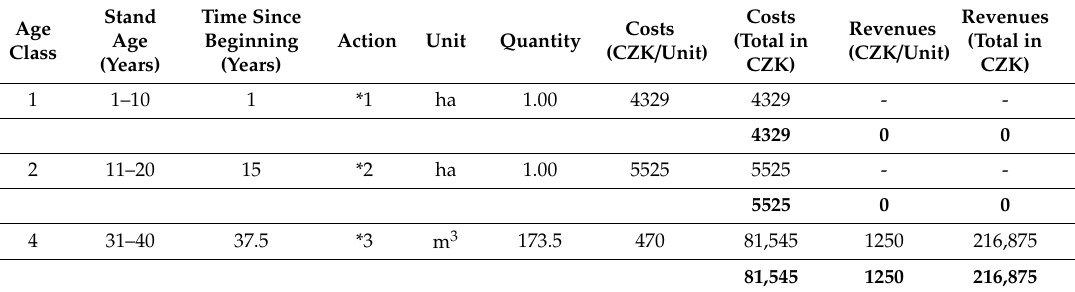
Table 4. Variant: Oak coppice forest, without game-proof fence.